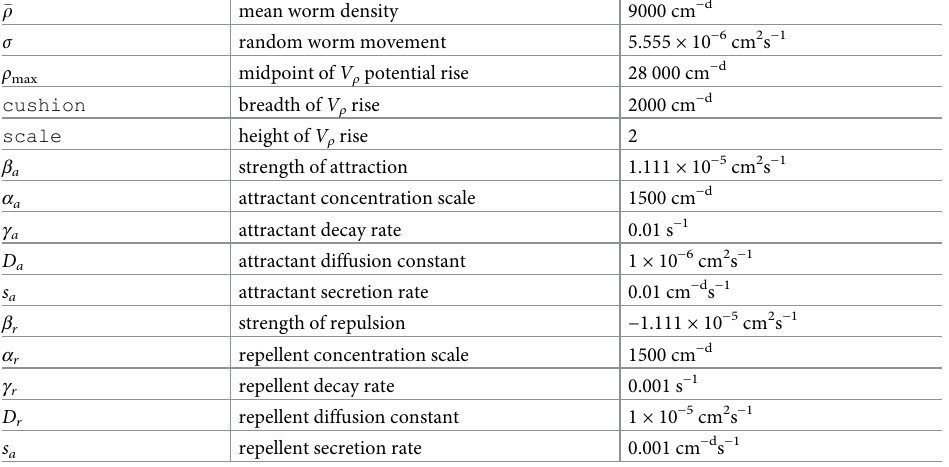
Table 2. Parameter